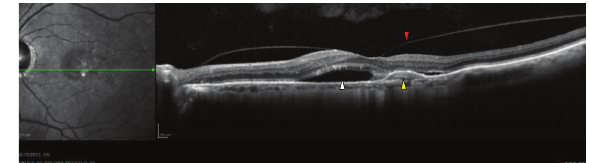
Figure 6: An OCT line scan of a 73-year-old man with exudative AMD. The white arrowhead shows that the hyporeflective space below the neurosensory retina is clearly visible, suggesting the presence of fluid. Yellow arrowhead represents a hemorrhagic detachment of theretinal pigment epithelium (PED)and vitreomac- ular traction in addition to vitreous alterations (red arrowhead).